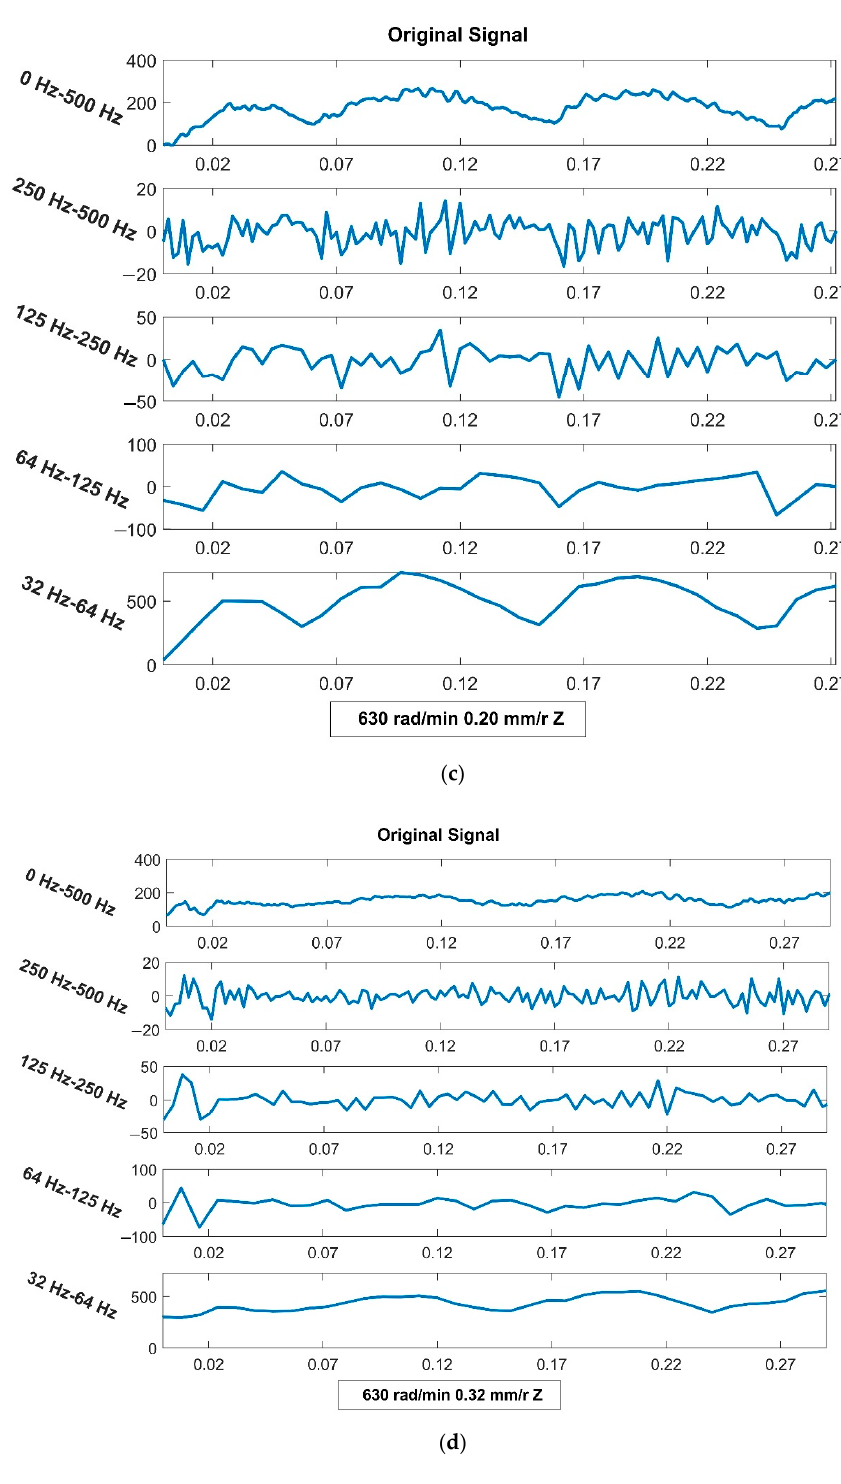
Figure 15. Results of wavelet analysis in the Z-direction when the feed rate is different and the rotational speed is constant. ( a ) The feed rate is 0.06 mm/r. ( b ) The feed rate is 0.13 mm/r. ( c ) The feed rate is 0.20 mm/r. ( d ) The feed rate is 0.32 mm/r. At different speeds, the vibrational trend is the same. The influence of the rotational speed on the axial vibration of the drill bit is less than that on transverse